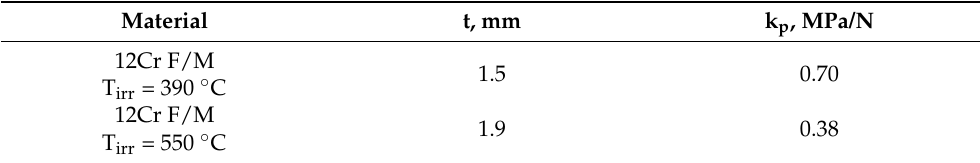
Figure 6. Dependence of σ max r = σ max on P for a specimen of 12Cr F/M steel, at T irr = 390 ◦ C (specimen thickness t = 1.5 mm) and for a specimen of 12Cr F/M steel, at T irr = 550 ◦ C (specimen thickness t = 1.9 mm).